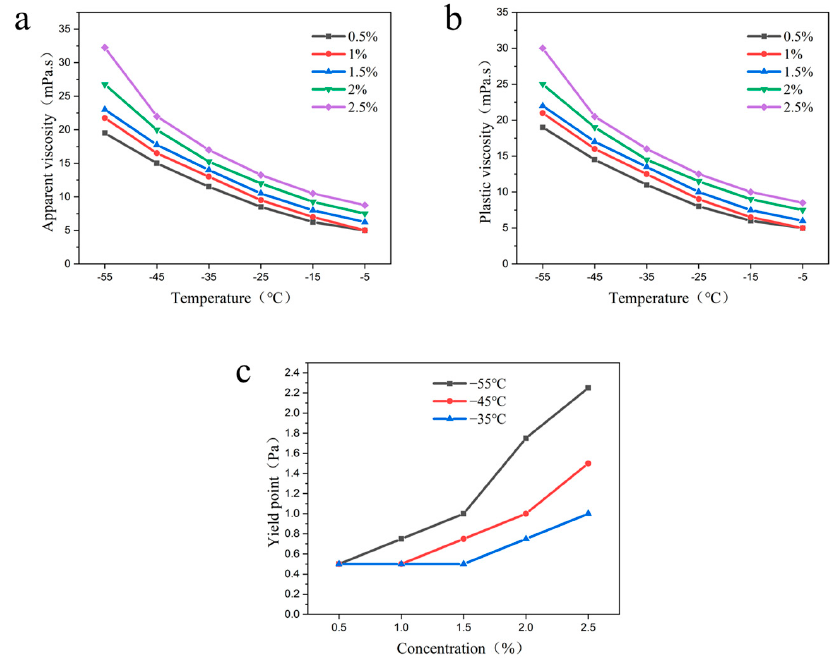
Figure 5. Effects of the different concentrations of organoclay on the rheological properties of the drilling fluid; ( a ) apparent viscosity; ( b ) plastic viscosity; ( c ) yield point.